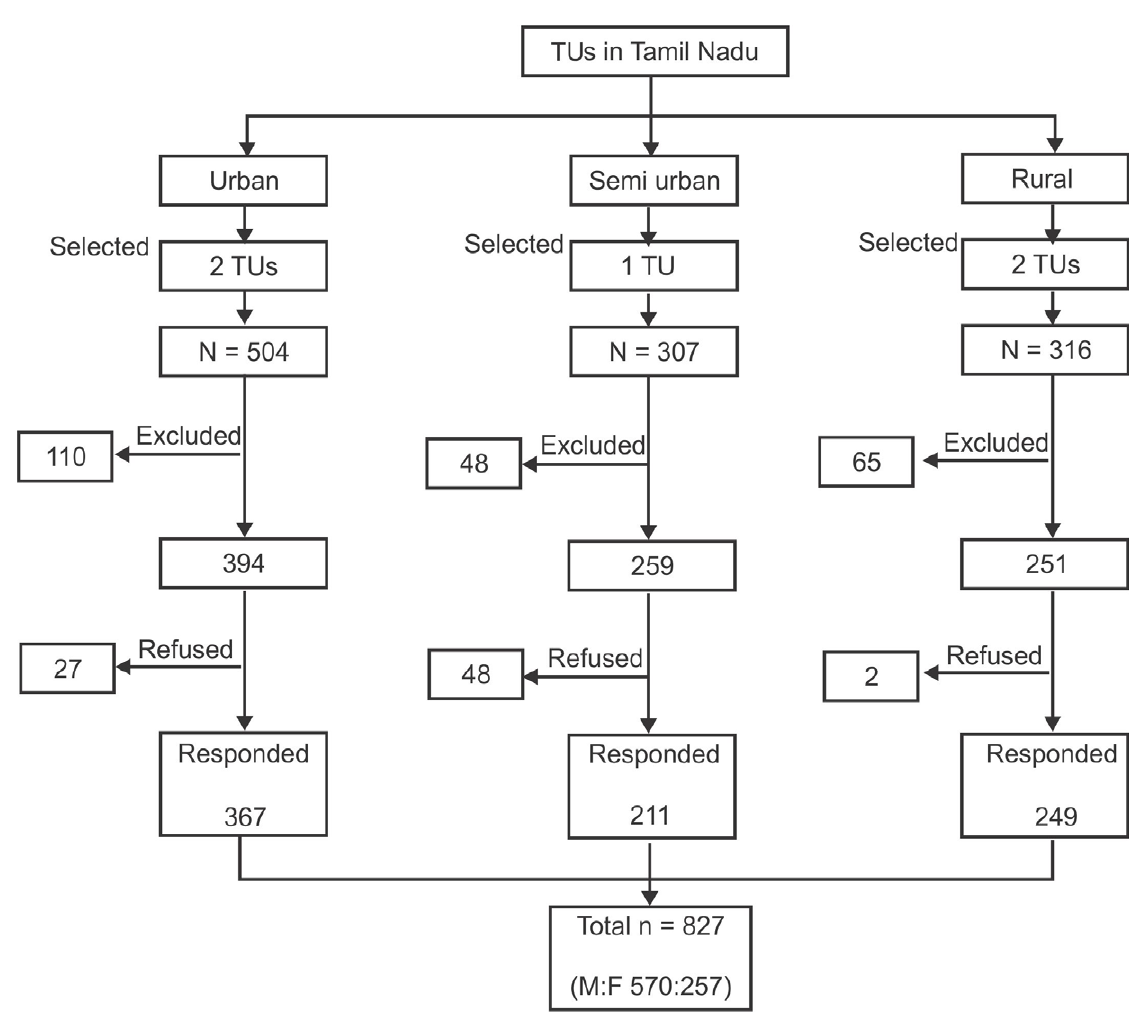
Figure 2. Flowchart showing the details of selection of study sites and study subjects. doi:10.1371/journal.pone.0041367.g002 Table 3. More than 80% in all the three groups were receiving Category-I treatment. A small proportion of patients were categorised as relapse, treatment defaulters, and failure cases in all categories of glucose intolerance and differences were not statistically significant [NonDM vs PreDM vs DM; Relapsed cases (5.8 vs 6.4 vs 8.6%), treatment defaulters (4.3 vs 6.9 vs 7.7%), and failure cases (1.4 vs 0.5 vs 0%)]. The median period of duration of